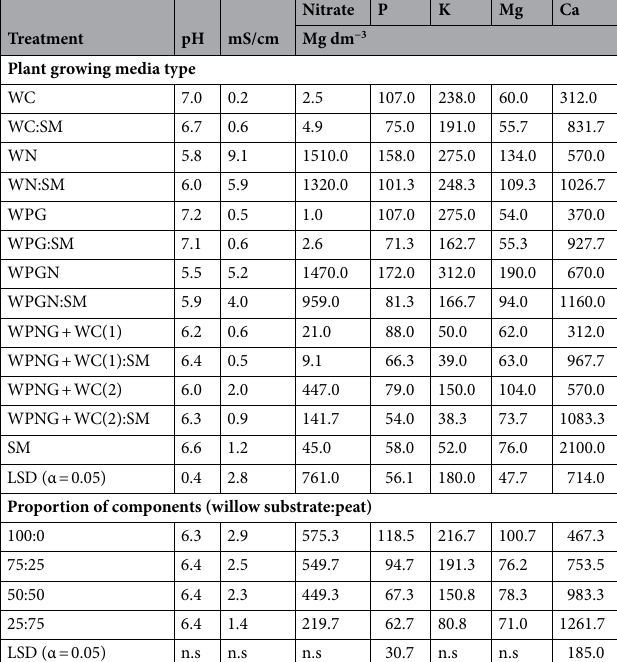
Measurement (weeks from